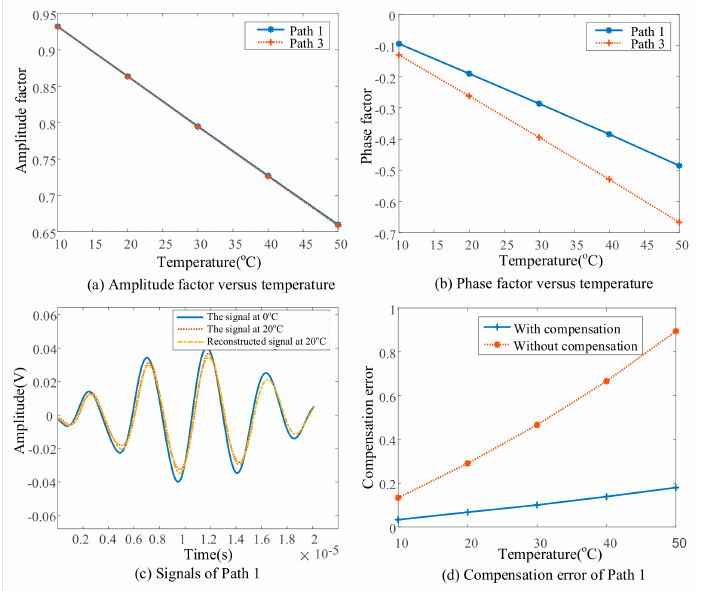
Figure 5. Simulation results of parameter